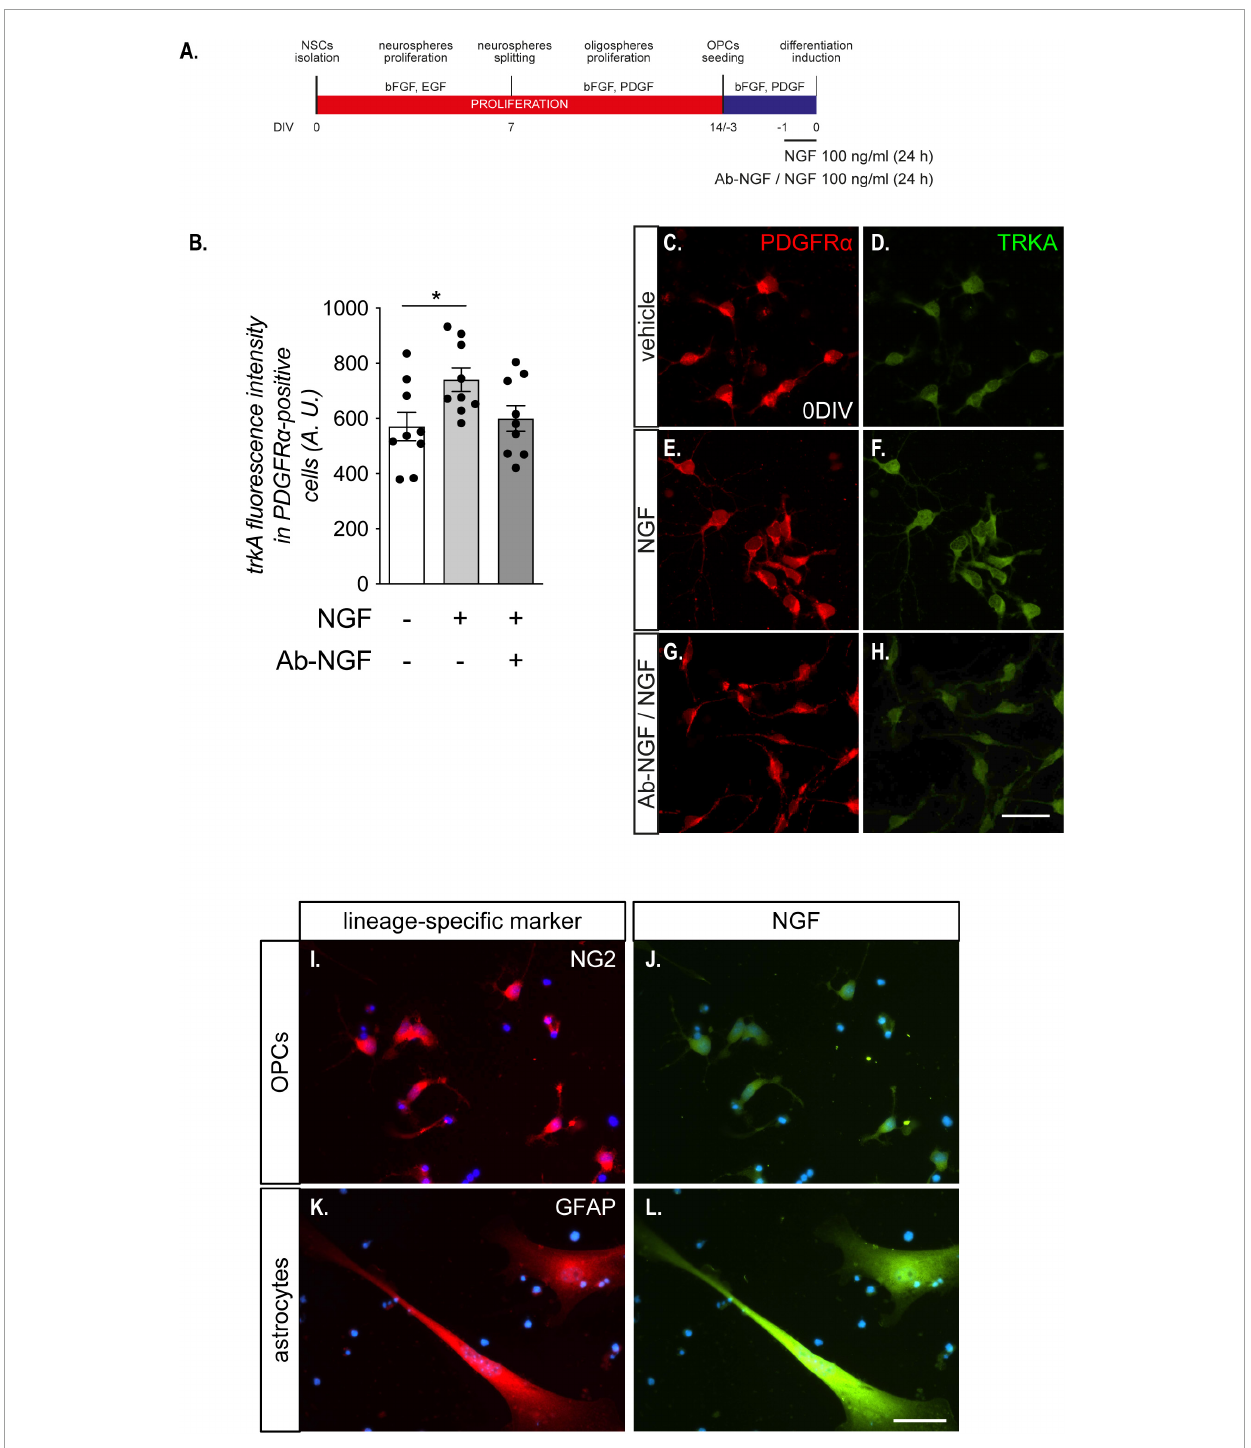
FIGURE2 OPCs are sensitive to NGF treatment. (A) NSC-derived mixed OPC/astrocyte cultures were exposed to NGF (100 ng/ml) for 24 h prior to T3-mediated differentiation induction. In an independent experimental group, a 1 h pre-incubation of the solution containing NGF was performed with the specific anti-NGF antibody (Ab-NGF), before adding the solution in the culture medium. (B) Graph shows the TRKA immunofluorescence quantification in PDGF α R-positive cells in cultures untreated (with bar, n = 8), treated (light gray bar, n = 9) with NGF, or treated with NGF after the neutralization with the Ab-NGF (dark gray bar, n = 9). (C–F) . Representative images of OPCs (PDGF α R-positive cells, panels C,E,G ), double positive for TRKA immunostaining (D,F,H) , treated with vehicle (C,D) , NGF (E,F) , or NGF neutralized by Ab-NGF (G–H) . Scale bar: 20 µ m. (I–L) Representative images of NG2-NGF (I–J) or GFAP-NGF (K–L) double stained NSCs-derived OPC cultures at DIV 0. Scale bar: 10 µ m. Bars represent mean ± SEM and single dots represent single images quantification, obtained from three independent experiments. Statistical analysis: Student’s t -test. Asterisks represent the differences between groups indicated by an horizontal line (* p < 0.05). A.U., arbitrary units; bFGF, basic fibroblast growth factor; DIV, day in vitro ; EGF, epidermal growth factor; NGF, nerve growth factor; PDGF, platelet derived growth factor; PDGF α R, platelet derived growth factor alpha receptor; T3, triiodothyronine; TRKA, high affinity nerve growth factor